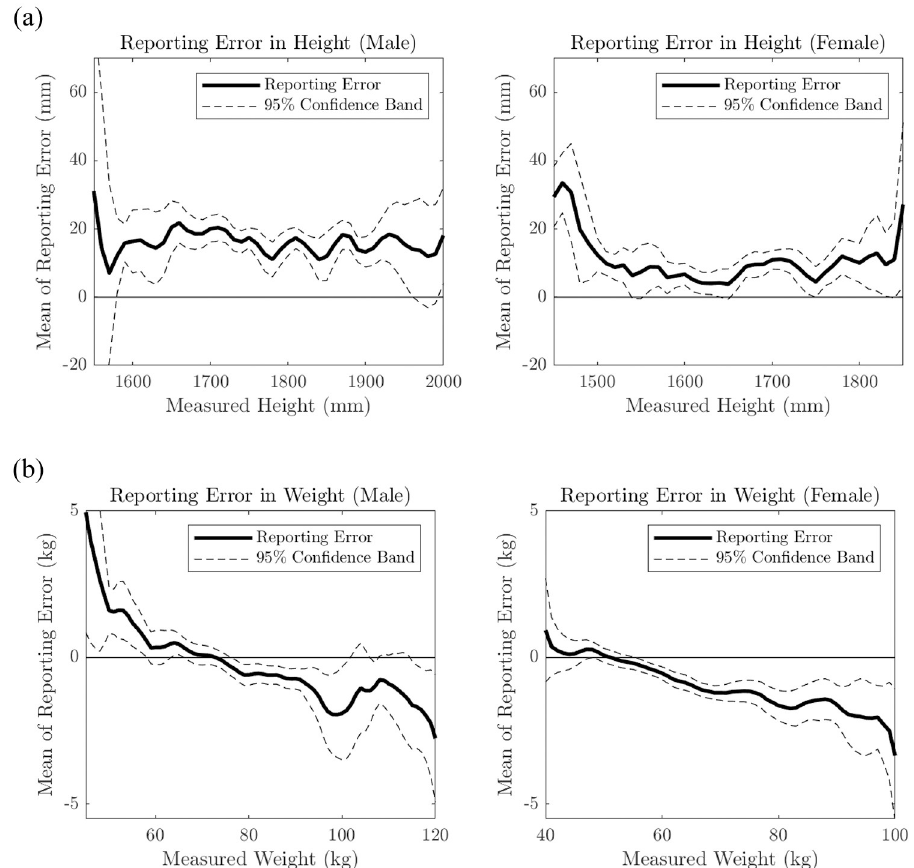
Fig 2. Relationship between reporting error and true measure. Conditional mean of reporting error in height conditional on true height (top) and reporting error in weight conditional on true weight (bottom).